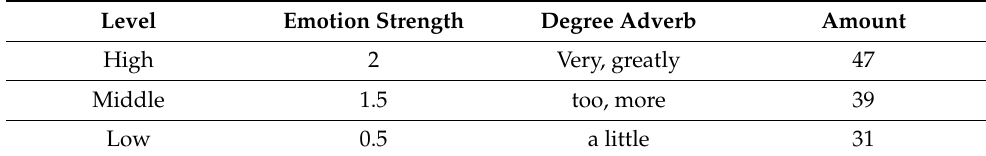
Table 11. Emotion strength of degree adverbs.